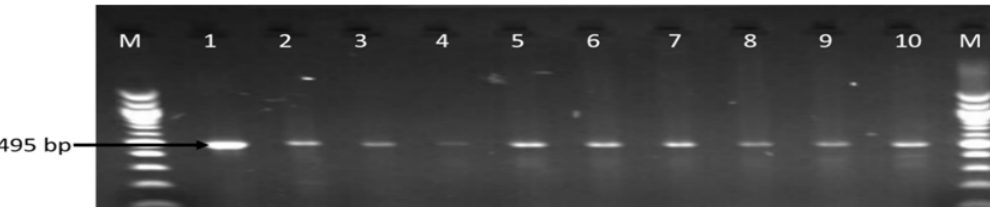
Figure 7. Gel image of some of the PCR detected cdtB gene. Lane M: DNA ladder, lane: 1–10: some positive Campylobacter isolates that harbor cdtB gene (495 bp).